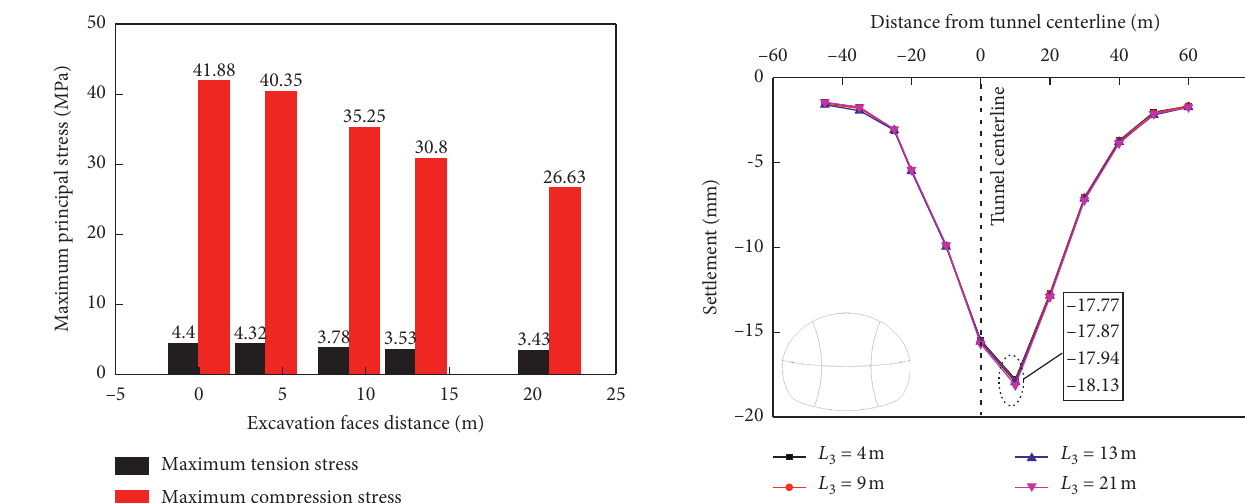
Figure 11: Surface subsidence curves of the CK9 +462